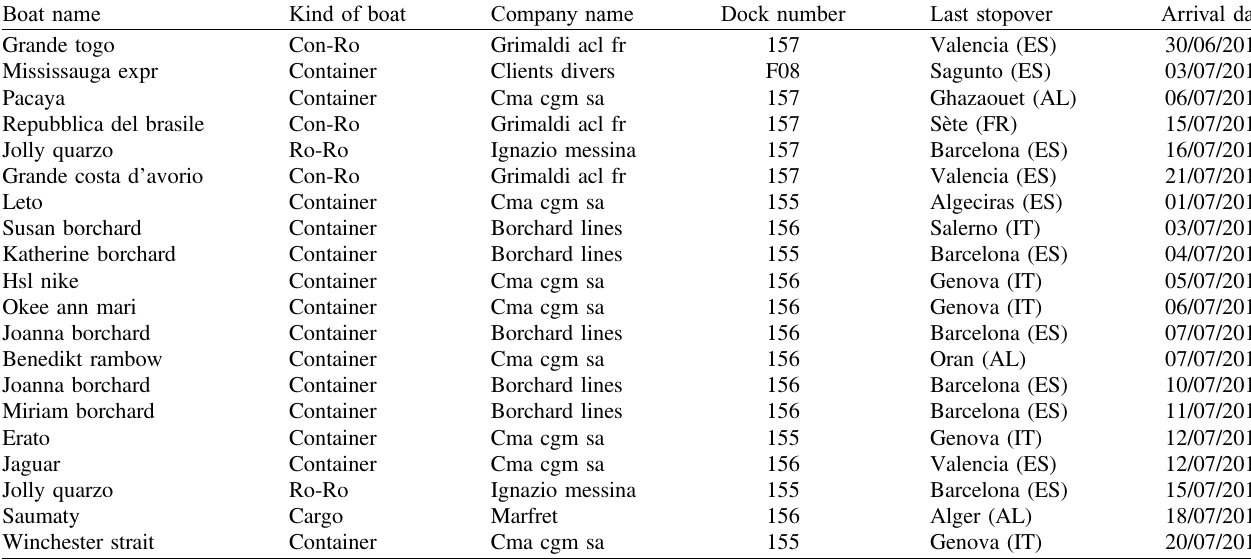
Table 2. Twenty riskiest boats docked between May and July 2018.